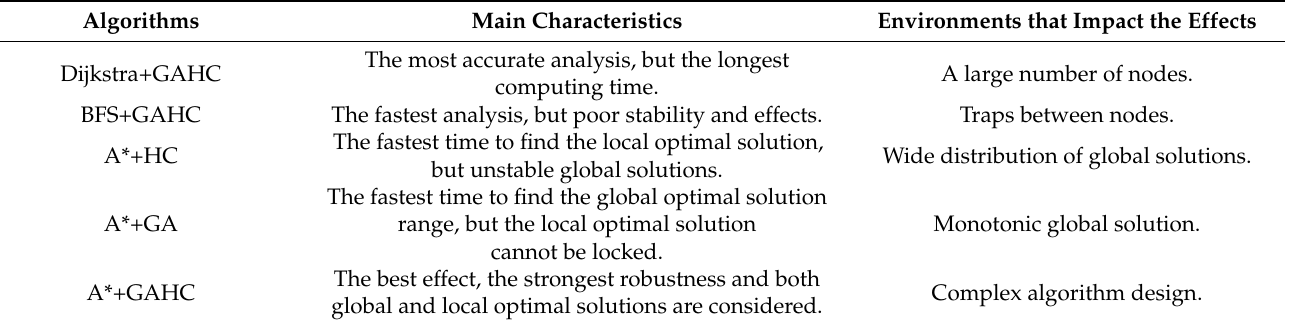
Table 7. Main characteristics and environments that impact the effects of each algorithm. Algorithms Main